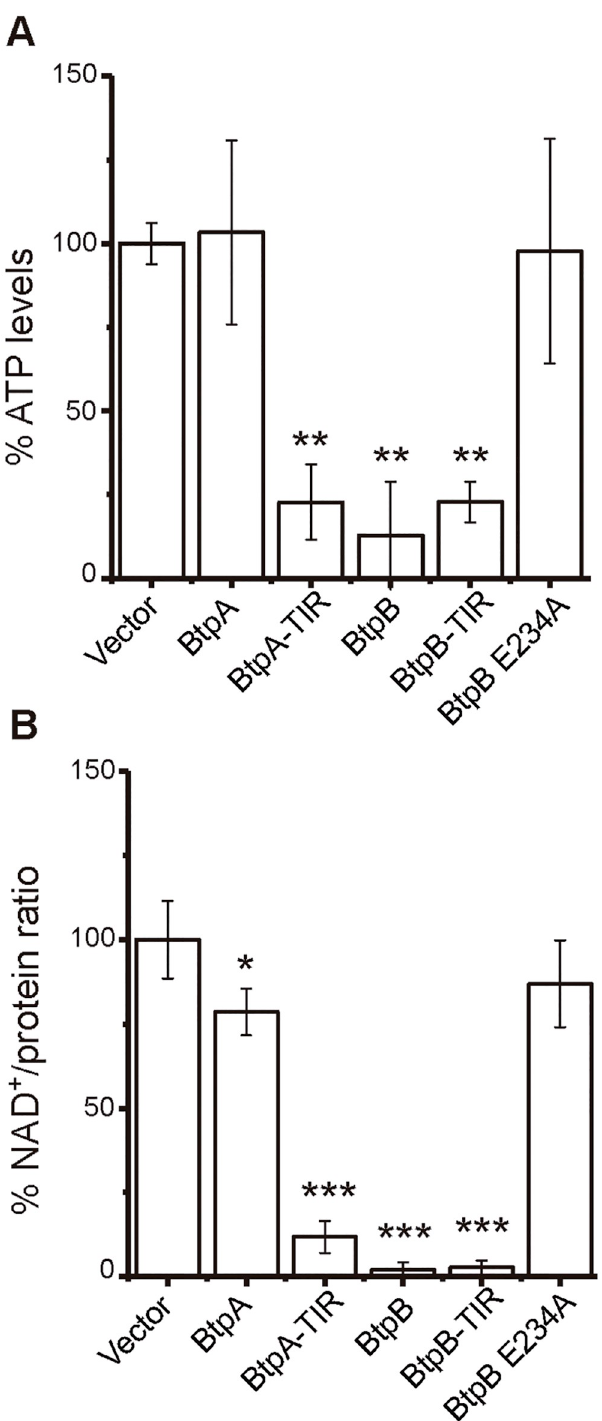
Fig 3. BtpB, BtpA-TIR and BtpB-TIR reduce NAD + and ATP levels when expressed in yeast. (A) Cellular ATP measurement by luciferase assay in YPH499 cells transformed with pYES2 empty vector and pYES2 plasmid derivatives bearing: both full-length and TIR domain versions of BtpA and BtpB and the catalytically inactive BtpB E234A mutant. Graph shows ATP levels as a percentage relative to the ATP levels measured on empty vector control cells. Results correspond to means ± standard deviation of three different transformants and statistical comparison was done with one-way ANOVA with p-values referred to vector of 0.0045 ( �� ) for BtpA-TIR, 0.0017 ( �� ) for BtpB